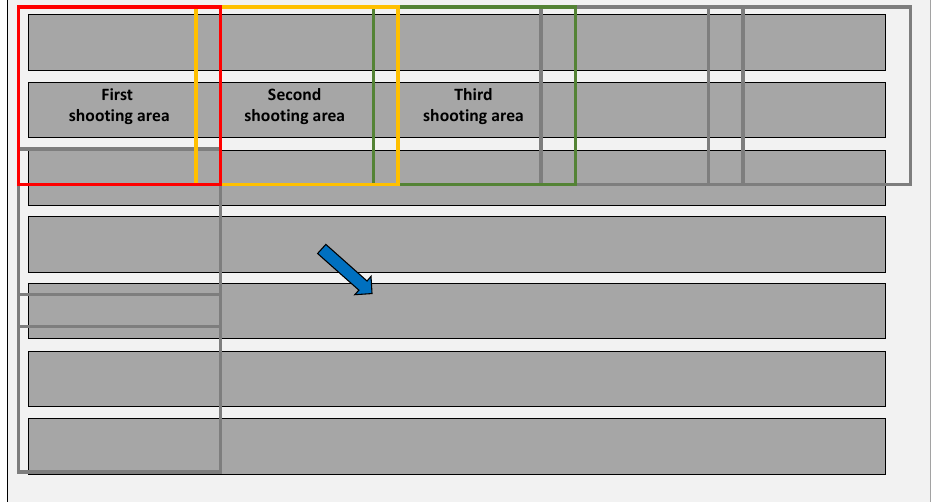
Figure 15. Data acquisition method.